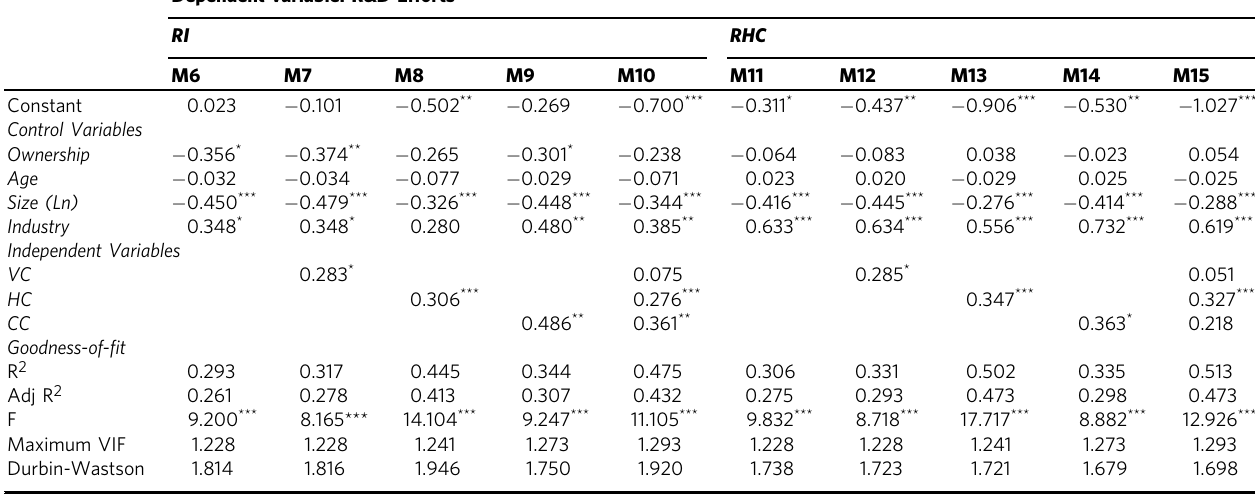
Table 4 The effects of external collaboration on R&D efforts.